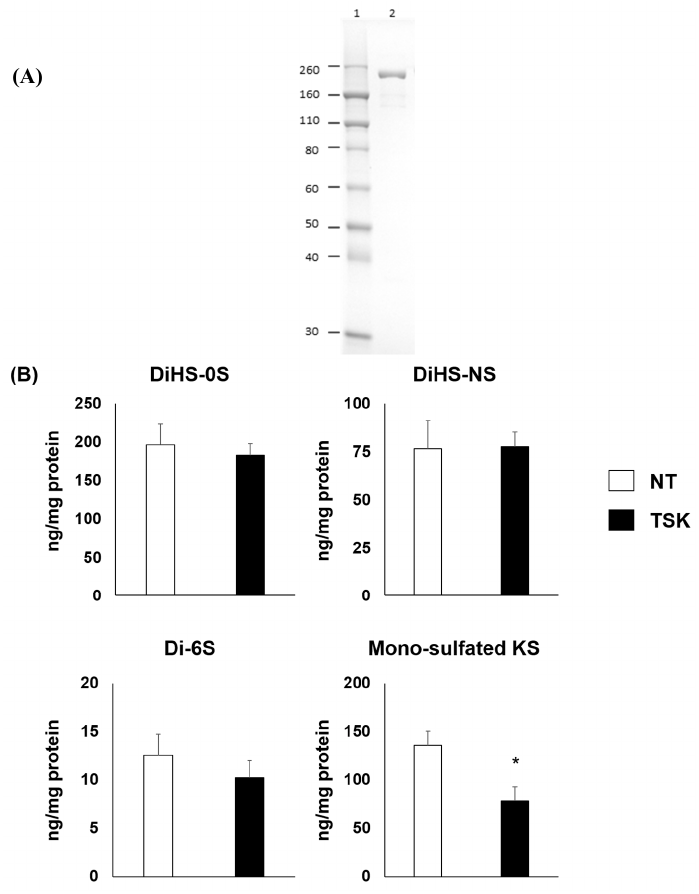
Figure 1. Purification and characterization of the thermostable keratanase. ( A ) SDS-PAGE of thermostable keratanase. The purified thermostable keratanase was applied to a 10% Tris-Glycine SDS-PAGE gel, and the proteins were visualized by Coomassie Brilliant Blue G-250 staining. Lane 1, markers; lane 2, purified enzyme (5 mU, 0.4 μ g). ( B ) Treatment with 1 μ U/mL purified thermostable keratanase degraded KS chains but not diHS-0S, diHS-NS and C6S chains in MPS IVA chondrocyte cells from 3-dimensional (3D) culture; n = 3. Statistics were analyzed by unpaired t -test. Data are presented as mean ± SD. * p < 0.05. C6S: chondroitin 6 sulfate, HS: heparan sulfate, KS: keratan sulfate, NT: untreated, TSK: thermostable